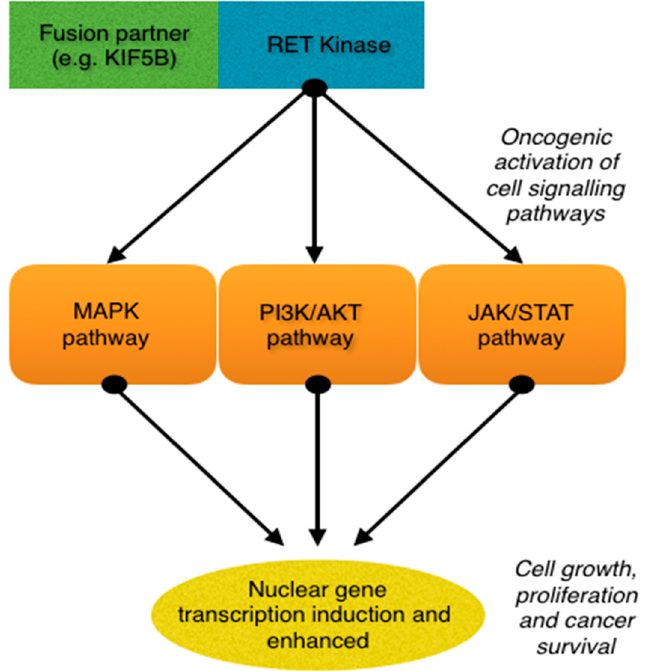
Figure 1. Rearranged during transfection (RET) fusion causing oncogenic activation of downstream intracellular signalling pathways .